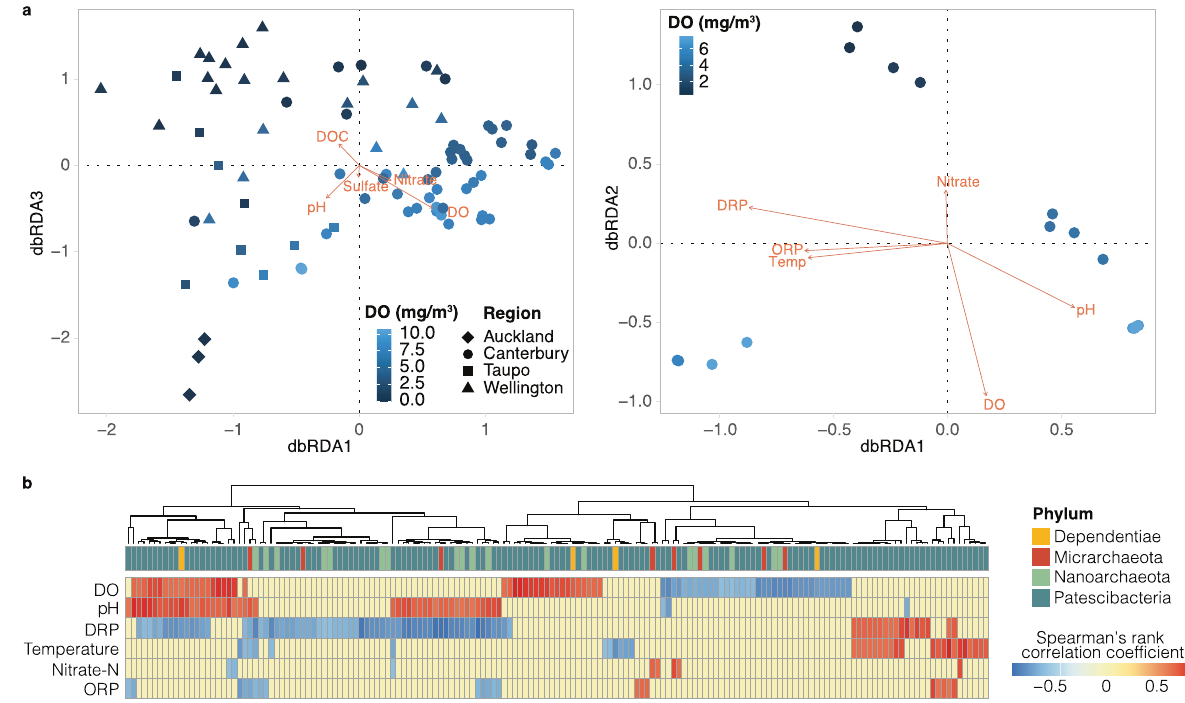
Fig. 4 In fl uence of environmental variables on ultra-small microbial communities. a Distance-based Redundancy Analysis (dbRDA) of Bray- Curtis dissimilarities between groundwater communities based on 16S rRNA gene amplicon (left) and MAG relative abundance data (right). Samples are colored according to groundwater dissolved oxygen (DO) concentrations (mg/m 3 ). The vectors indicate fi tted environmental variables signi fi cantly correlated to dbRDA coordinates (permutation test, p < 0.05, permutations = 999). For amplicons, the categorical variables region and lithology were also signi fi cant ( p = 0.001 each), while DRP, temperature and conductivity were not signi fi cant. For MAGs, sample type was not signi fi cant. Only variables measured for all samples and not signi fi cantly co-varying were tested. b Heatmap showing pairwise Spearman ’ s rank correlations between MAG relative abundance and environmental parameters signi fi cantly correlated with differences in ultra-small microbial communities based on dbRDA (right plot in a). Only signi fi cant Spearman ’ s rank correlations are shown for each MAG ( p < 0.05). MAG phyla af fi liations are indicated by the topmost